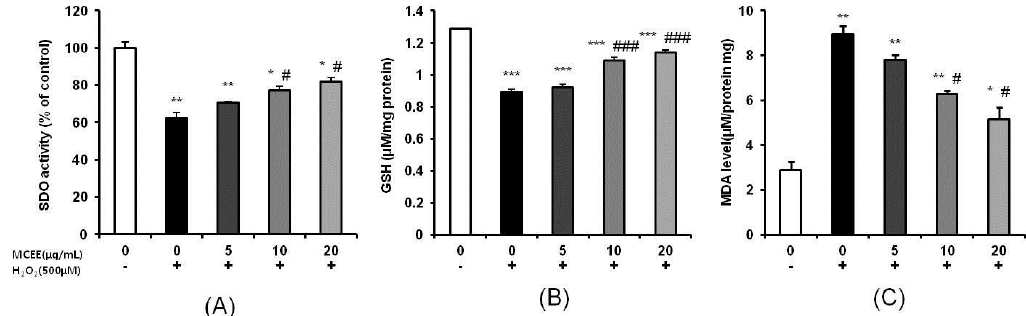
Figure 3. Effects of MCEE on ( A ) superoxide dismutase (SOD) activity, ( B ) reduced glutathione (GSH), and ( C ) malondialdehyde (MDA) levels in H 2 O 2 -treated cells. Cells were pretreated with the MCEE for 24 h and then treated with H 2 O 2 for 4 h. Data are shown as means ± S.D. ( n = 3). * p < 0.05; ** p < 0.01; *** p < 0.001 compared with the untreated control cells, # p < 0.05; ### p < 0.001 compared with only H 2 O 2 -treated cells.